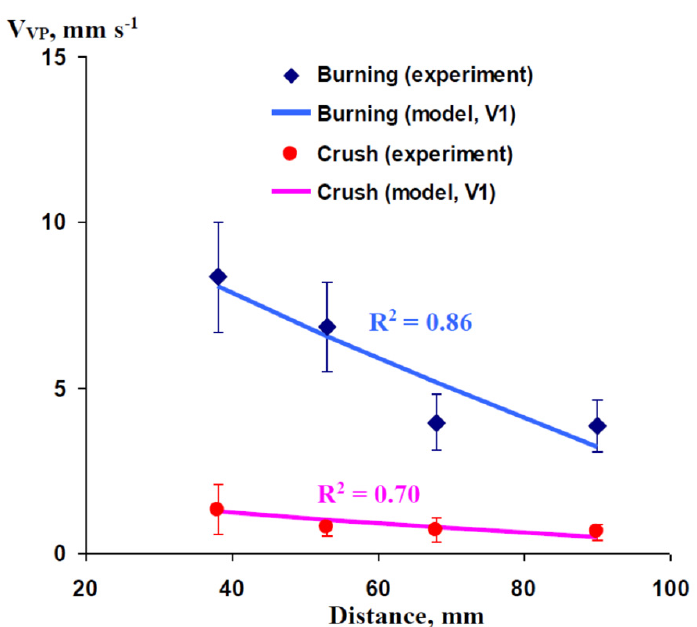
Figure 3. Experimental and simulated dependence of the rates of propagation of variation potential (V VP ) on the distance from the damaged zone in pea seedlings. We used experimental data from our previous work [63], which analyzed the propagation of variation potential for 275 mm. The duration of hydraulic changes in the damaged zone (t R ) is assumed as 50 s (for burning) or 325 s (for crush). The ratio of the P’ integral, which is necessary for variation potential induction, to the total P 0 ’ integral in the zone of damage (N) is assumed as 0.58 (for both burning and crush). Only Variant 1 of the model (V1) of the model was used in this analysis (see Figure 1b). It is assumed that V1 (instant initial increase in pressure and subsequent linear decrease) is in accordance with the action of short-term burning or mechanical wounding. R 2 is the determination